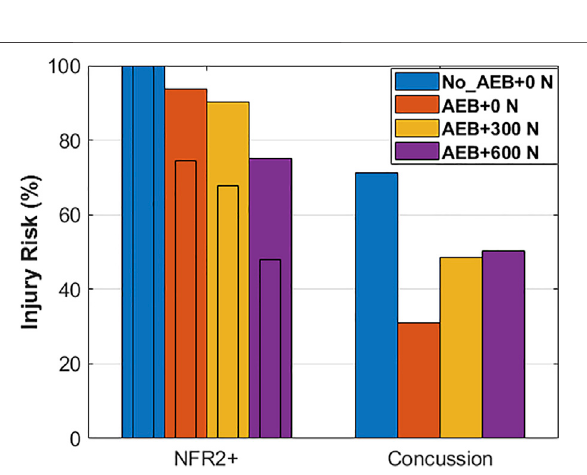
FIGURE 4 | NFR2+ risk for 45-year-old (narrow bars) and 65-year-old (wide bars) male occupants, and AIS2 concussion risk for a male occupant of unspeci fi ed